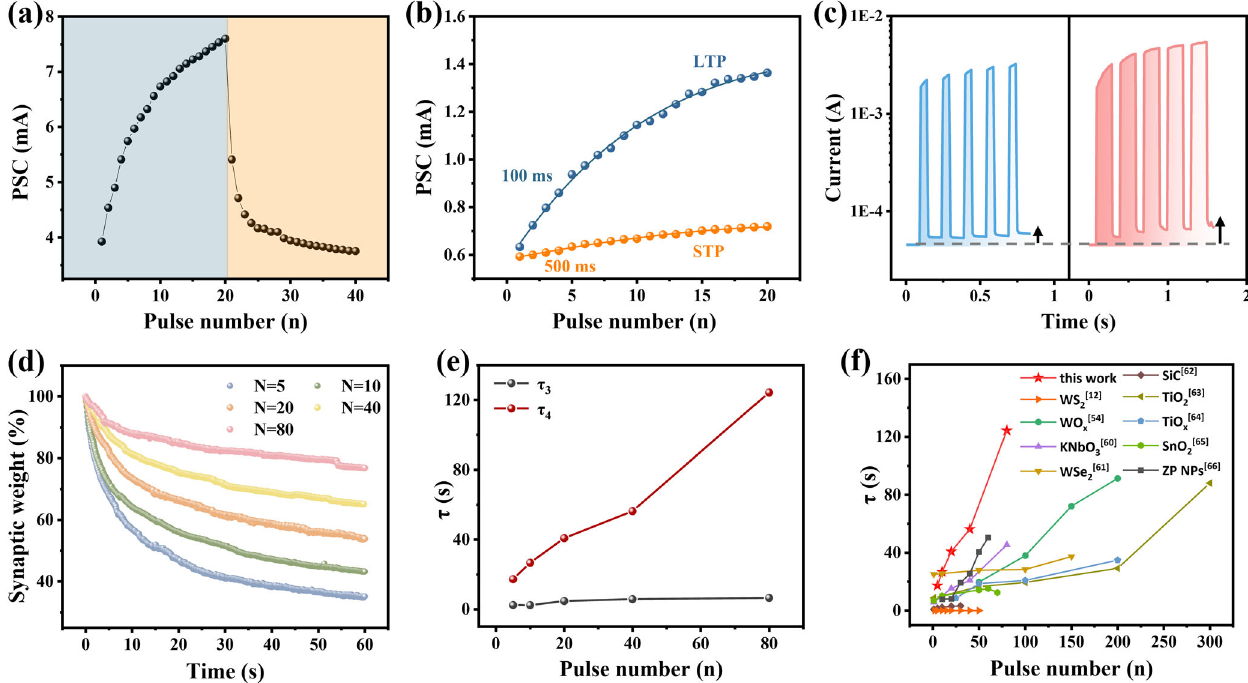
Fig. 5 Arti fi cial synaptic characteristics of the memristor, including STP, LTP, LTD, and transitions from STP to LTP. a PSC values with the increasing of pulse number (pulse amplitude of 8/ − 8 V, width of 100 ms, interval of 100 ms, and read voltage of 0.1 V), mimicking potentiation/depression behaviors of a biological synapse. b PSC values versus the pulse number at pulse interval of 100 ms and 500 ms. c Pulse curves for the device after application of a sequence of presynaptic pulses with different width (100 and 300 ms), and same pulse interval of 100 ms. d Retention curves for synaptic weight after different numbers of identical presynaptic pulses (pulse amplitude of 8 V, width of 1000 ms, interval of 1000 ms and read voltage of 1 V). e The distribution of time constants obtained by fi tting. f Comparison of time constants for different